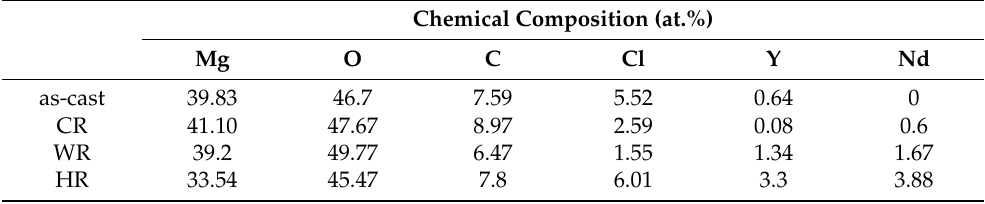
Table 5. Chemical composition of the surface corrosion products on WE43 Mg alloys. Chemical Composition